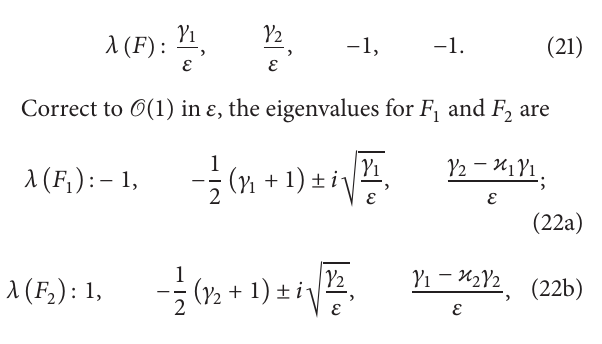
Table 1: Existence and stability conditions of nonnegative equilibria of system